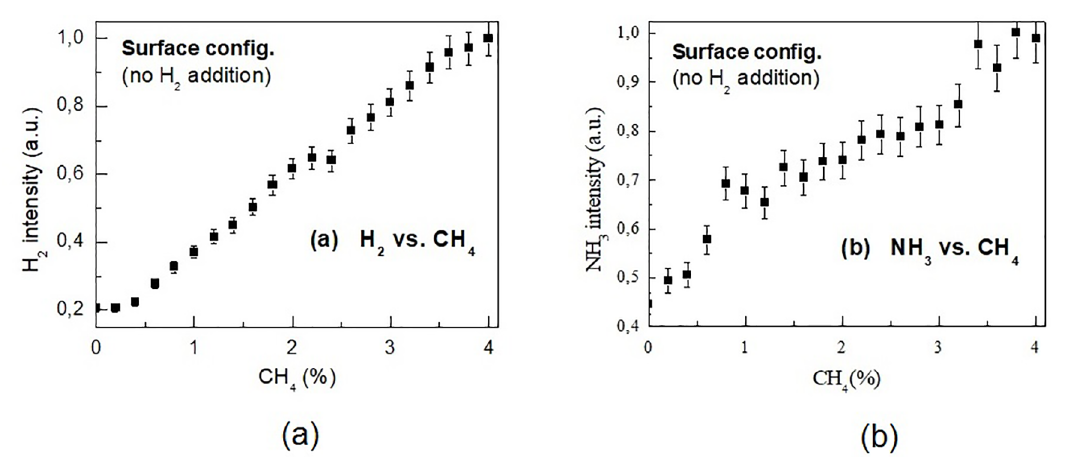
/CH mixture. and (b) 2 4 /CH 2 4